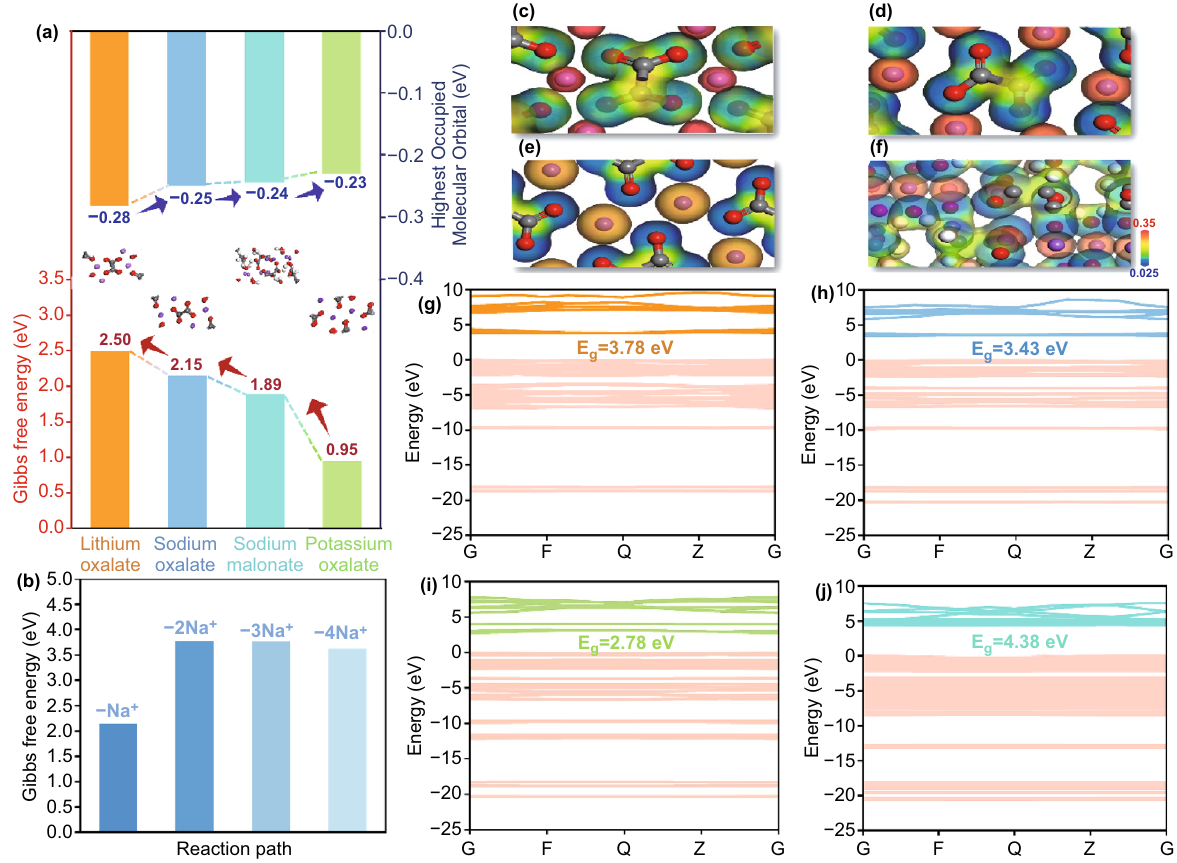
Fig. 1 DFT calculations of M 2 C 2 O 4 (M = Li/ Na/K) and sodium malonate. a Relative comparation of HOMO levels and Gibbs free energies (the insets are corresponding molecular structures). b Desodiation process of sodium oxalate. Electrostatic potential plots c - f and band structures g - j of Li 2 C 2 O 4 , Na 2 C 2 O 4 , Na 2 C 2 O 4 and Na 2 H 2 C 3 O